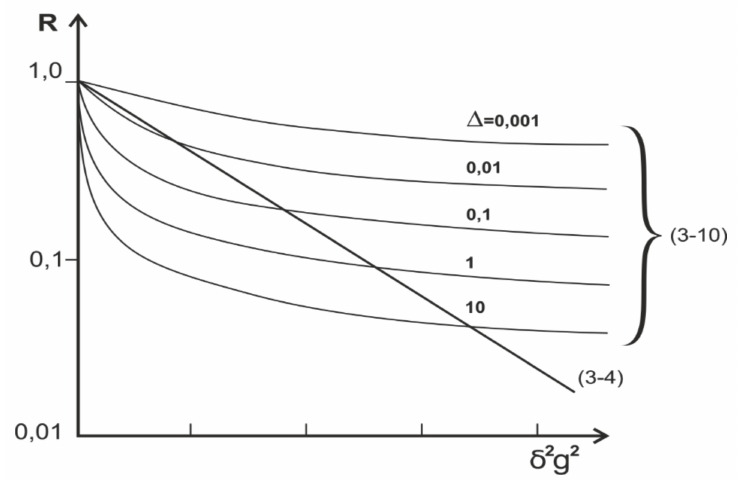
(cid:0) (cid:1) δ 2 g 2 for the case of diffusion in a free volume